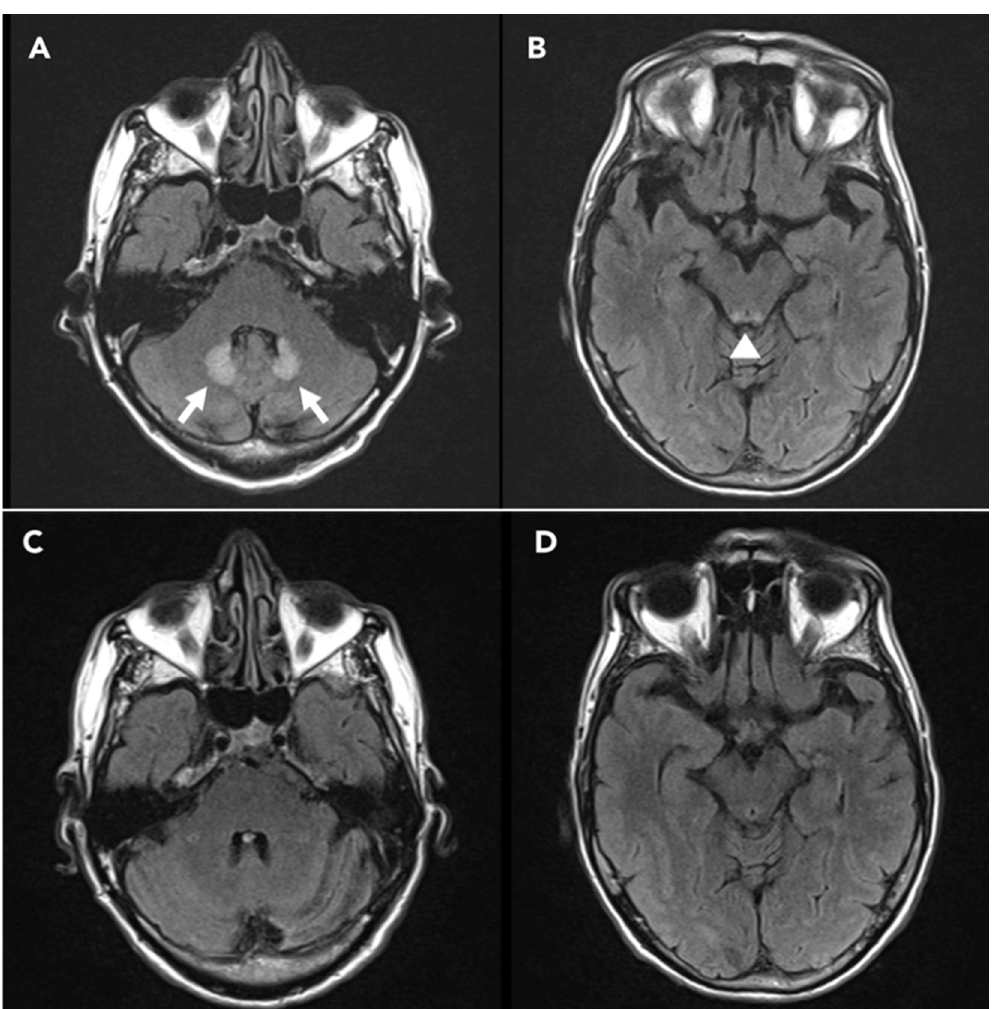
Figure 2. (cid:31) 1.5 Tesla brain MRI. Fluid-attenuated inversion recovery (FL(cid:31) IR) sequences showing Figure 2. A 1.5 Tesla brain MRI. Fluid-attenuated inversion recovery (FLAIR) sequences showing hyperintensity in ((cid:31) ) bilateral dentate nuclei of the cerebellum (arrows) and (B) dorsal midbrain hyperintensity in ( A ) bilateral dentate nuclei of the cerebellum (arrows) and ( B ) dorsal midbrain (arrowhead). A follow-up MRI performed one month after metronidazole discontinuation did not show any abnormalities ( C , D